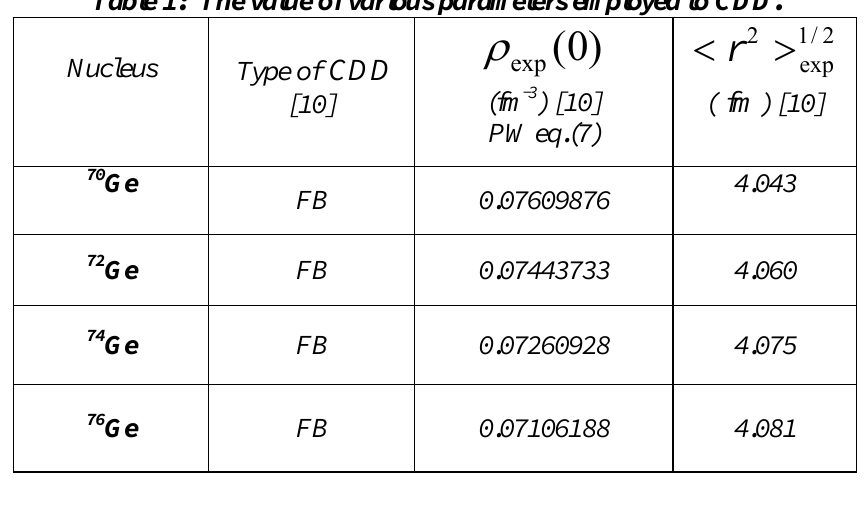
Table 2: Calculated parameters used in Eq. (3), To calculate CDD and occupation number in 1f-2p of nucleus and the calculated